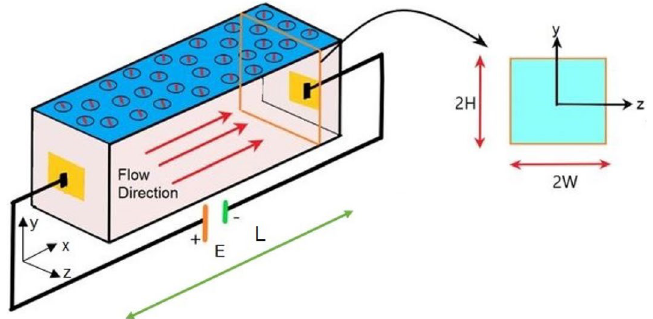
Figure 1. Plots depict the schematic view of the microfluidic channel that is considered in this study. The channel dimensions with the coordinate system, are shown with the zoomed-in view of the y − z